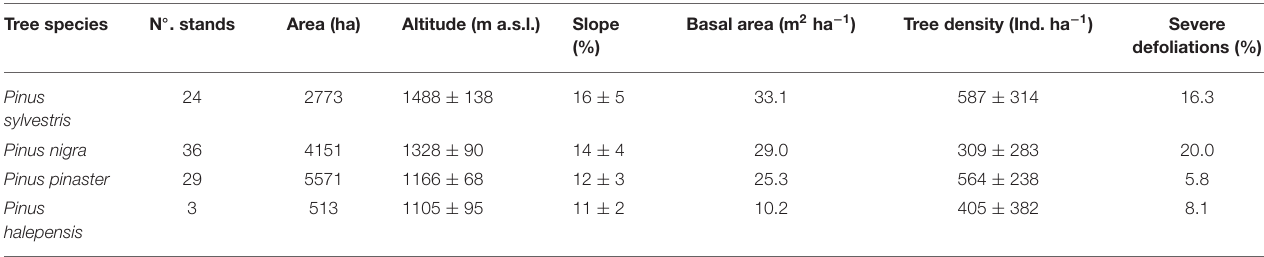
Values are means ± SD. The number of stands corresponds to those where the pine species accounted for more than 50% of the basal area. Defoliation data are the means for the period 1970-2011 and severe defoliations were considered those with levels 3, 4 and 5 observed during that period in stands dominated by each pine